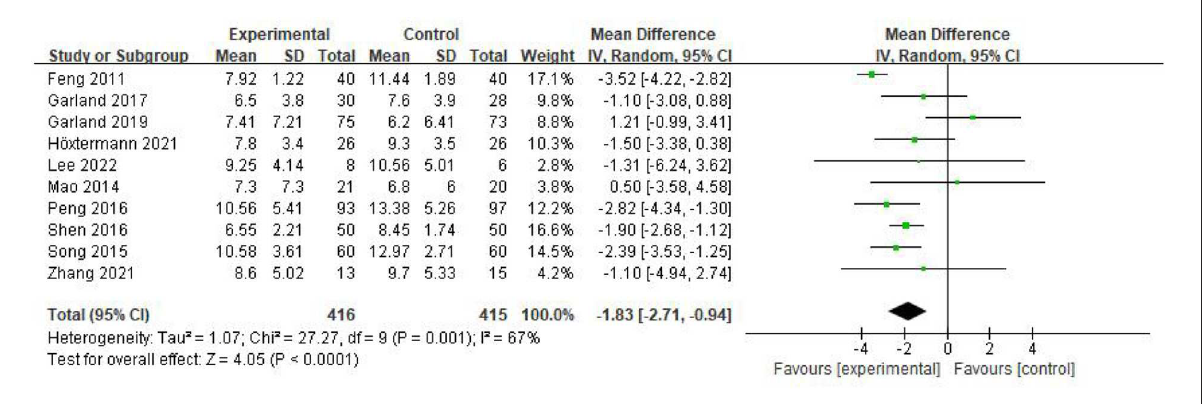
FIGURE3 Forest plot of PSQI scale scores.